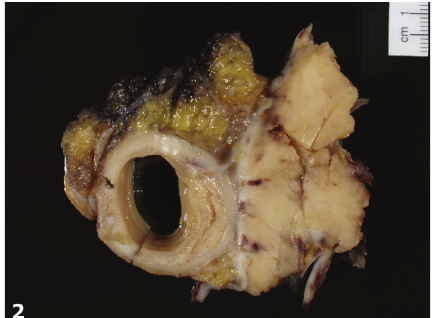
Figure2:Grossphotographdemonstratingatan-whitemassarising from the serosal surface of the sigmoid colon.